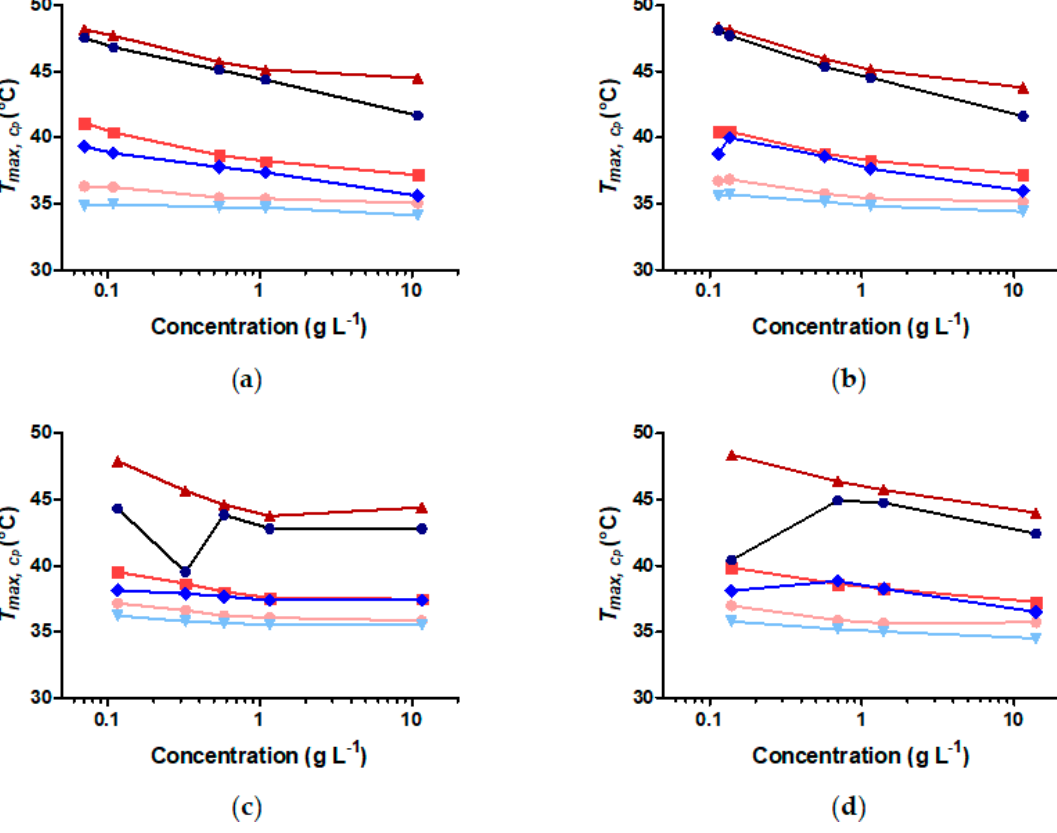
Figure 7. Temperature of maximum 𝑐 (cid:3043) ( 𝑇 (cid:3040)(cid:3028)(cid:3051),(cid:3030) ) of each deconvoluted transition peak plotted vs. (cid:3291) nanoparticle concentration. The red curves represent the heating curves and the blue curves the cooling curves. The light red and light blue curves represent the inner shell, red and blue curves represent the intermediate shell and dark red and dark blue curves the outer shell. ( a ) FeOx-5; ( b ) FeOx-7; ( c ) FeOx-10; ( d ) FeOx-21.